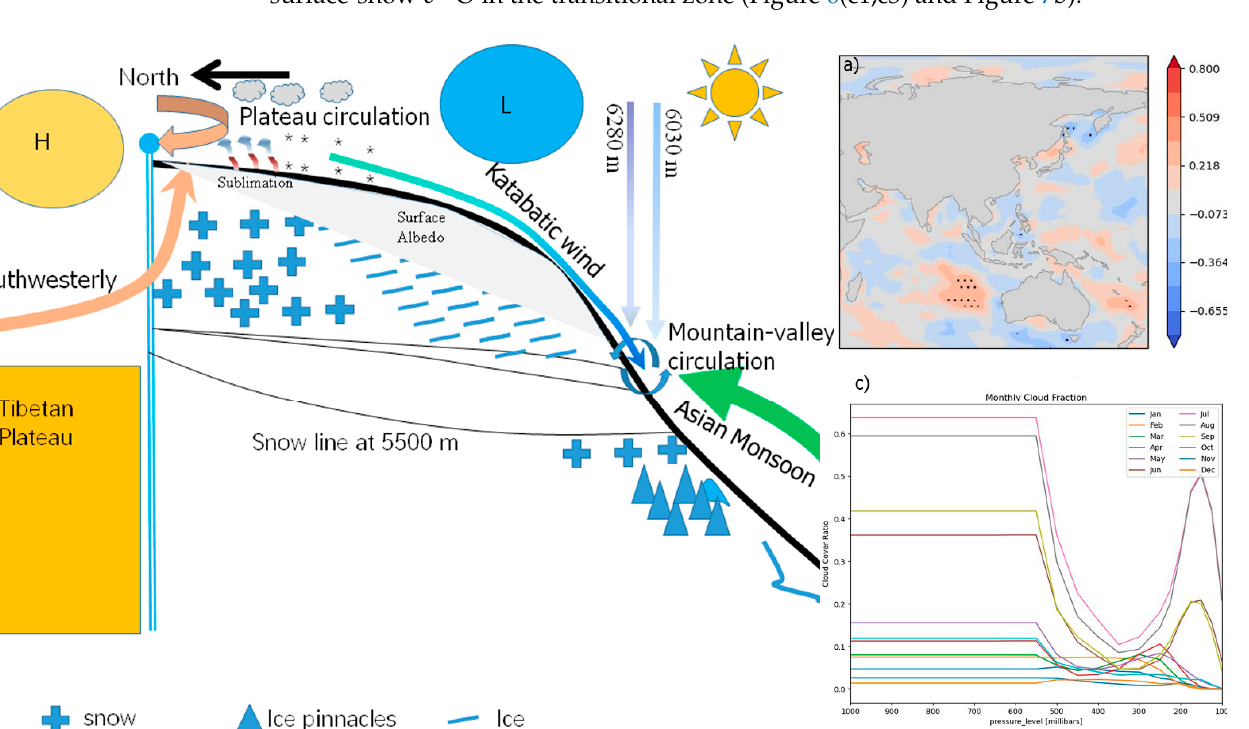
Figure 7. Hypothetical mechanisms for the transition and verification using reanalysis data. ( a ) correlation of anomalies between d excess in snow with relative humidity based on daily data throughout the sample periods, ( b ) schematic figure of possible circulation streams and interactions on the southern slope of the Himalaya, and ( c ) cloud fraction over corresponding grid (27.9 ºN, 86.8 ºE) from EAR5.